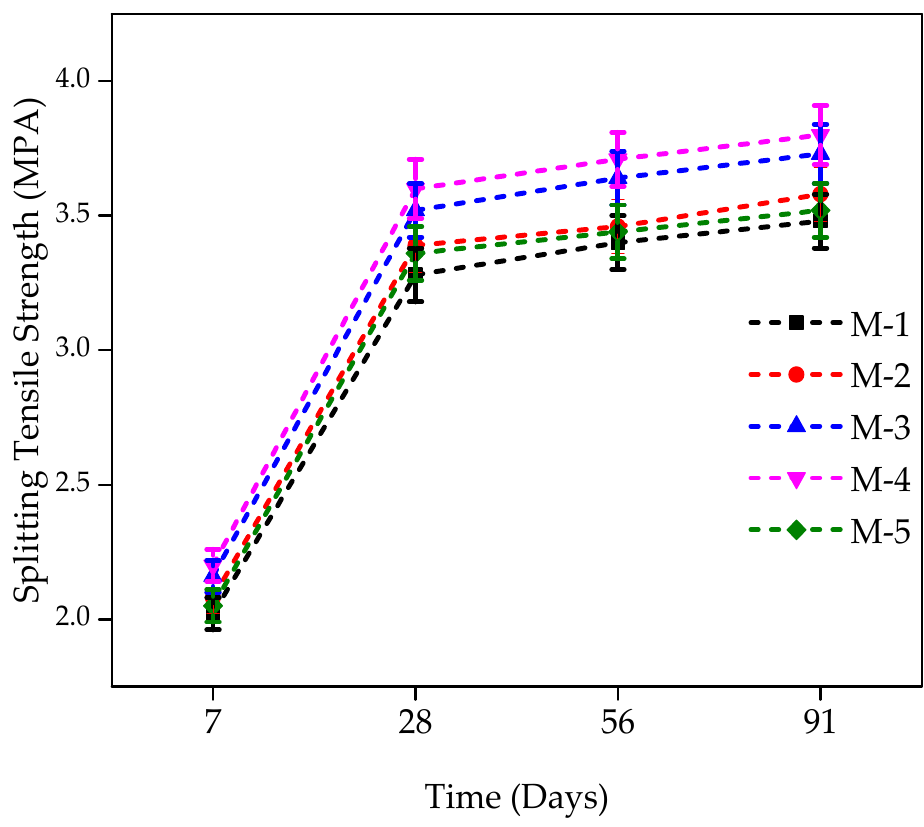
Figure 5. Splitting tensile strength development of WFS concrete at various ages [48].